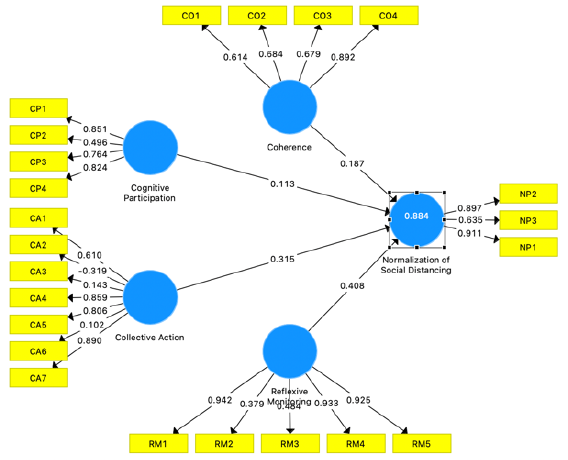
Figure A2. Model Generated on the First Iteration.